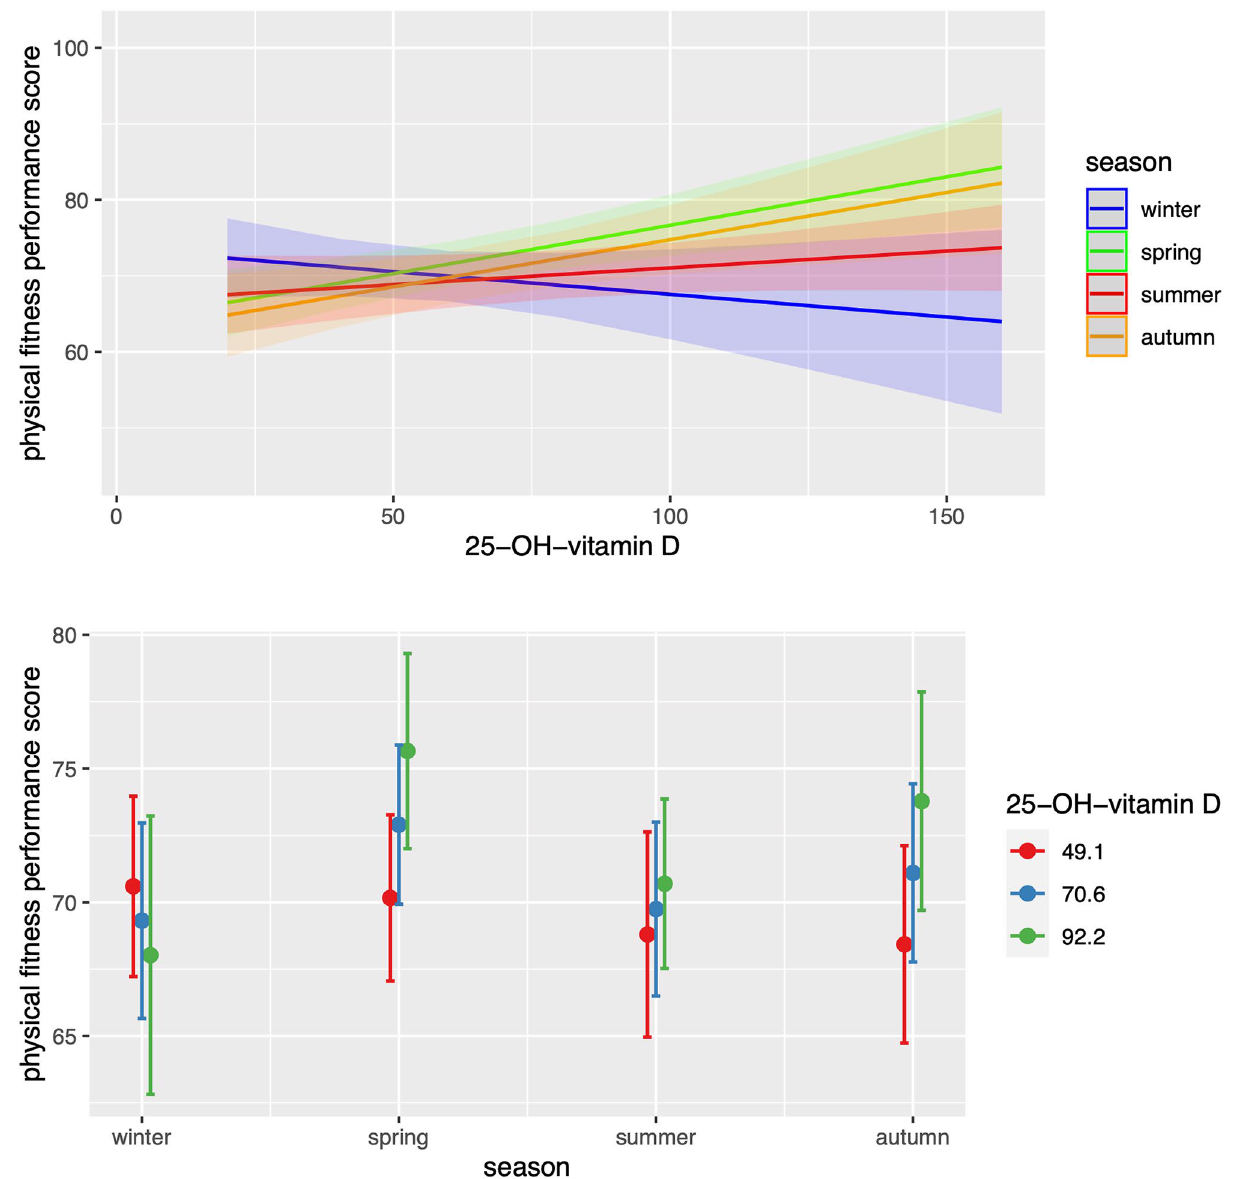
Figure 1. Predicted physical fitness performance scores across different seasons and total 25-OH-Vitamin D values. Results were obtained from the final multiple regression model selected, which included the interaction term between season and total 25-OH-Vitamin D values, as well as the following main effects: body fat percentage, mid-upper arm circumference, season, recreational physical activity level, site of recreational physical activity, smoking, time spent per day for gaming/TV watching, hemoglobin, creatinine, and total 25-OH-vitamin D. All the model predictors that are not specified in the interaction term were held constant. Upper panel: season-specific regression lines and 95% confidence intervals for increasing values of total 25-OH-Vitamin D on the x-axis. Lower panel: season-specific predicted physical fitness performance scores and 95% confidence intervals for three combinations of total 25-OH-Vitamin D values representing the mean (70.6 nmol/L, blue-center) minus or plus 1 standard deviation [49.1 nmol/L (red-left) and 92.2 nmol/L (green- right),